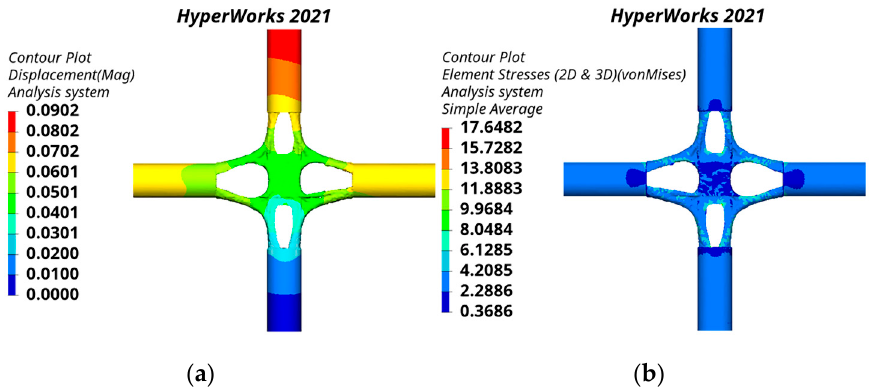
Figure 13. Static analysis results of the traditional substructure topology-optimized joint: ( a ) displacement nephogram, ( b ) equivalent stress nephogram.